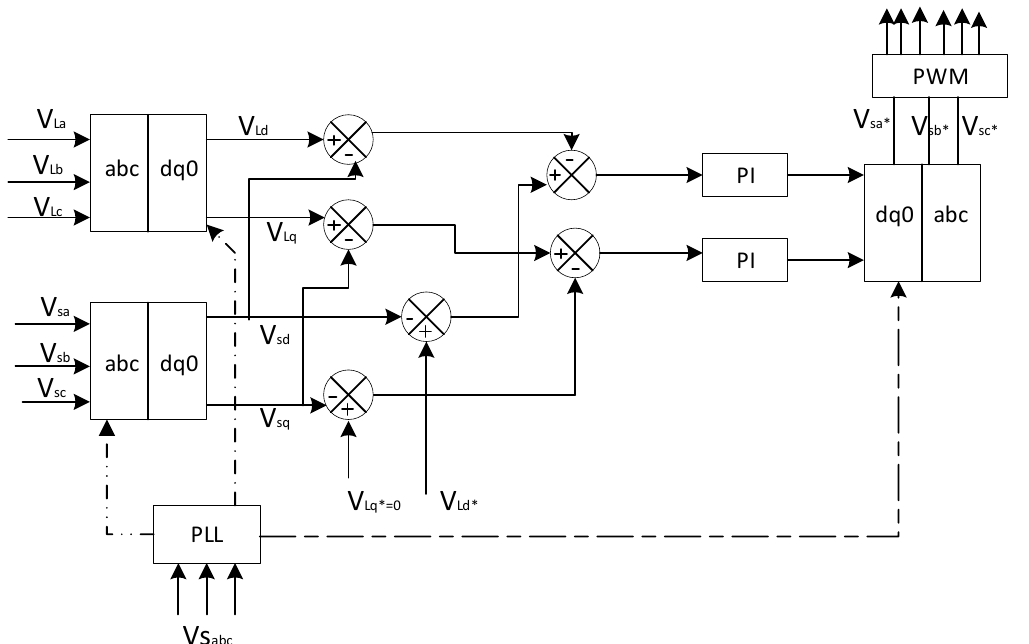
Figure 5. Conventional control strategy of series active power filter.